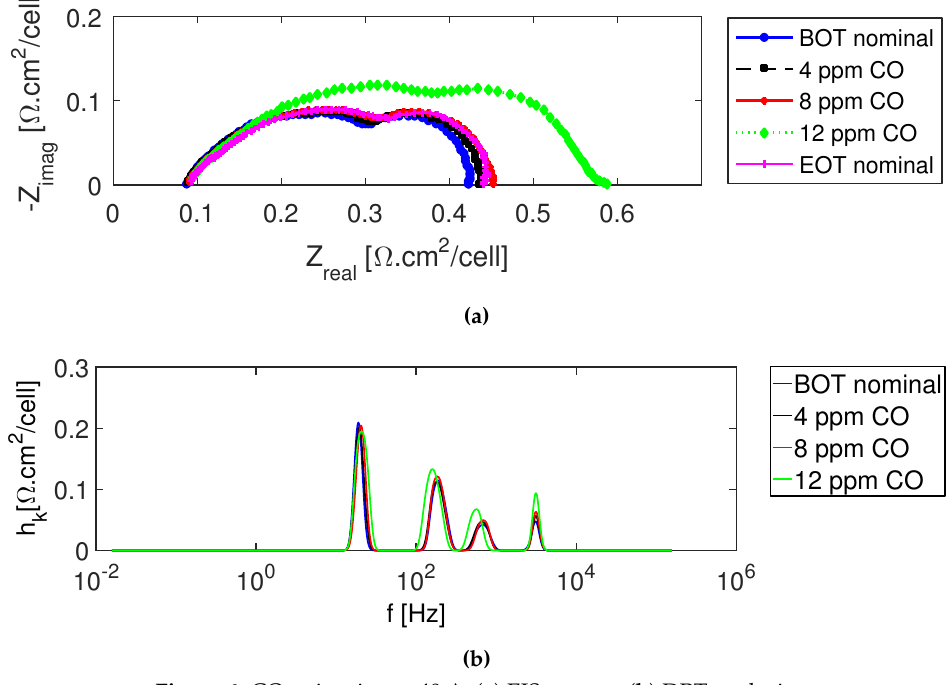
Figure 6. CO poisoning at 40 A: ( a ) EIS spectra; ( b ) DRT analysis.